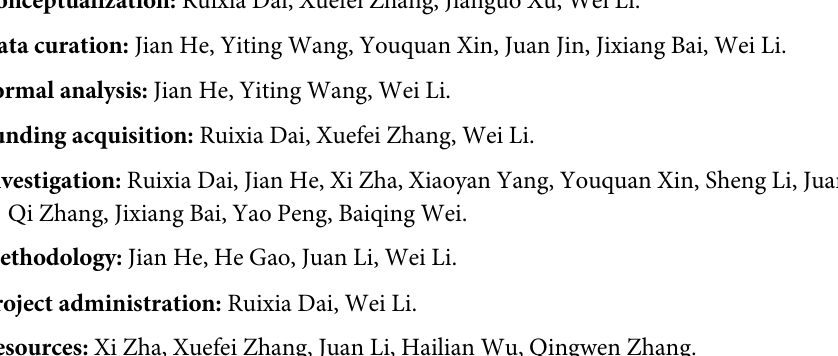
S1 Table. Primers used in this study. S2 Table. The sequenced strains of Y . pestis using in this study. S1 Fig. Sequence comparisons of rrs